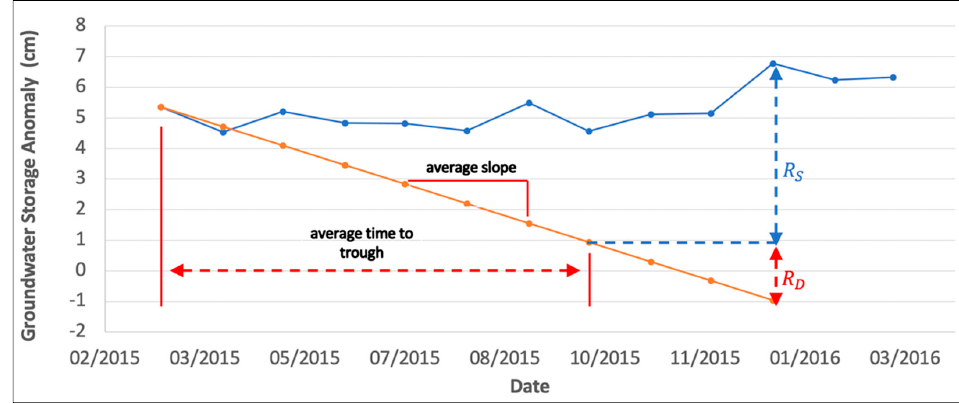
Figure 16. 2015/02 to 2016/03 in the Iullemeden basin.